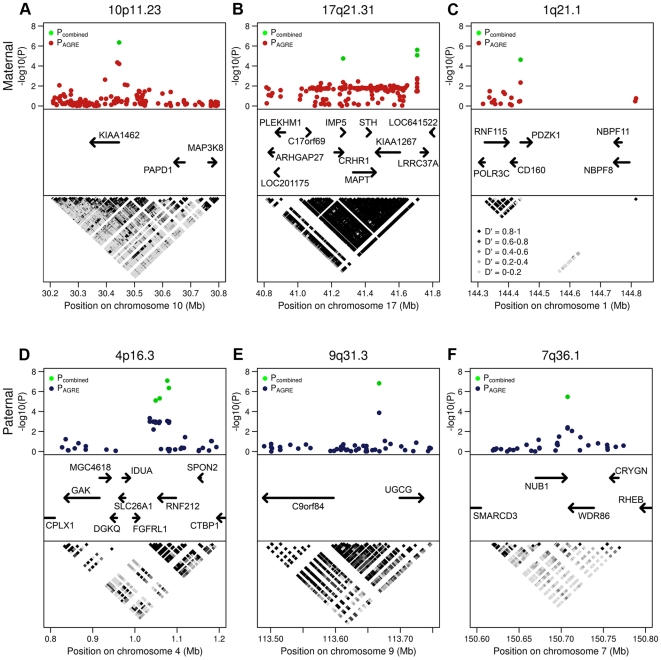
Genomic regions that include the 6 most significant loci associated with recombination phenotypes.(A–C) Maternal association results for SNPs from analysis of the AGRE samples (red) and combined AGRE and FHS samples (green) plotted for loci on chromosomes 10p.11.23 (A), 17q21.31 (B), and 1q21.1 (C). (D–F) Paternal association results for SNPs from analysis of the AGRE samples (blue) and combined AGRE and FHS samples (green) plotted for loci on chromosomes 4p16.3 (D), 9q31.3 (E), and 7q36.1 (F). The top panel of each figure highlights the most significant SNPs in the region. The center panel of each figure shows genes in each region, and direction of transcription. The bottom panel of each figure shows LD patterns at each locus, where black corresponds to stronger LD and light gray corresponds to weaker LD as shown in (C).